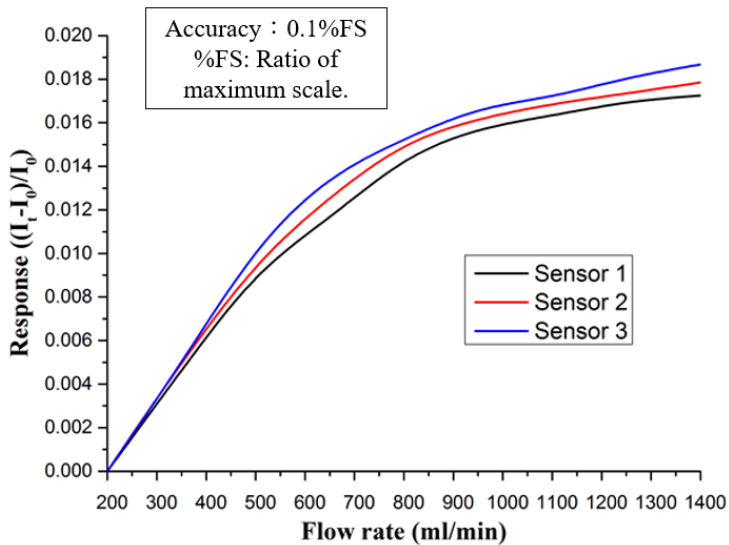
Figure 6. Dimensionless calibration curve of micro flow sensor.